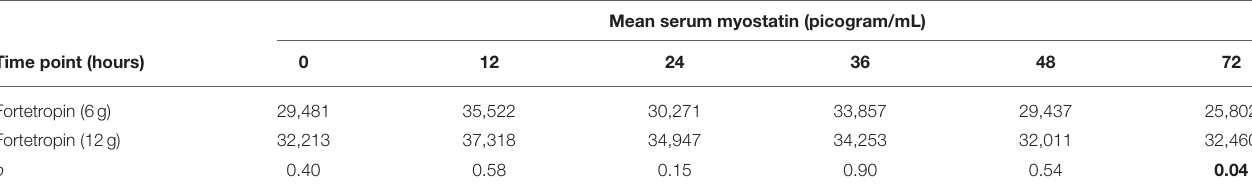
TABLE 2 | Comparison of mean serum myostatin (pg/mL) of low dose treatment (Fortetropin) compared to high-dose treatment for each time point.